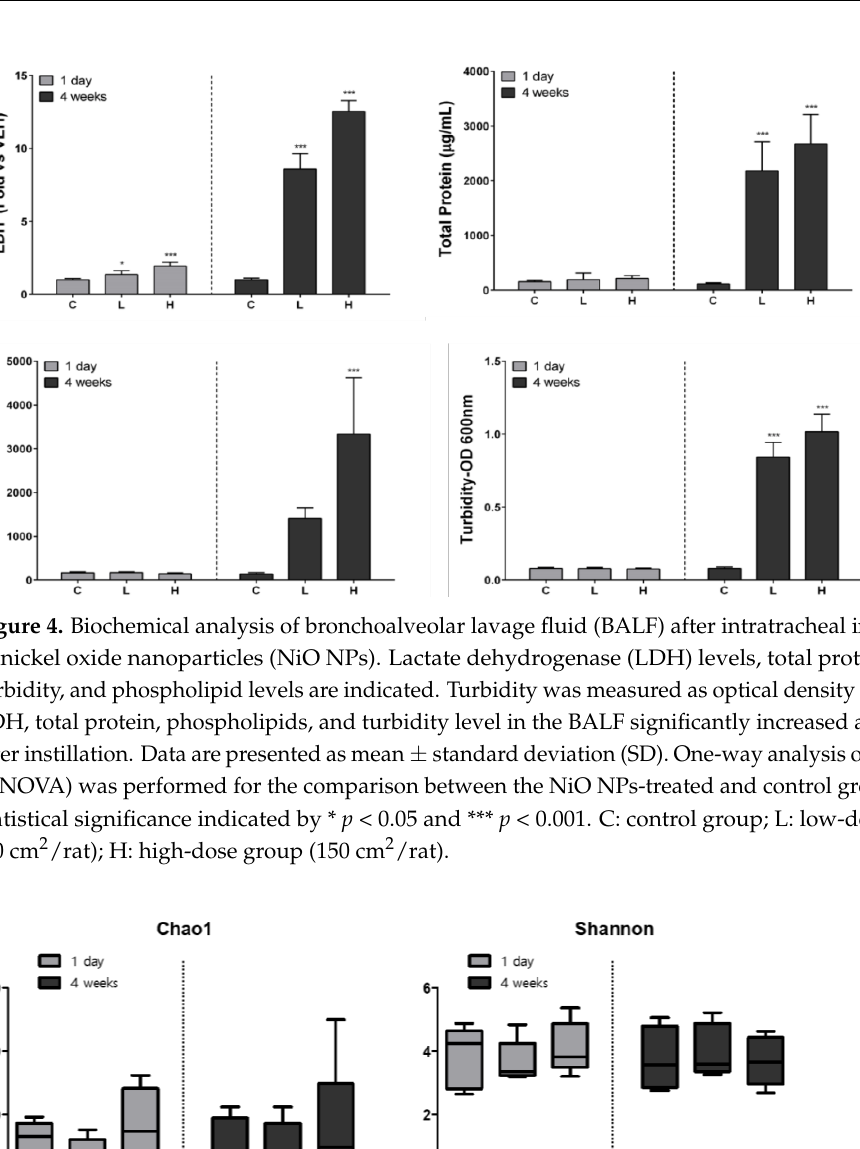
Figure 5. Alpha diversity, which estimates bacterial diversity and species richness. Bacterial diversity (Shannon; right side) and richness estimates (chao1; left) are divided into two groups, reflecting 1 day (light gray) and 4 weeks (dark gray) after intratracheal instillation of nickel oxide nanoparticles (NiO NPs), by using a boxplot. Community diversity and richness were evaluated using the alpha diversity and were not significantly different between exposure groups of NiO NPs and control group. Median values are shown as a line within the box and error bars indicate the standard error of the samples C: control group; L: low-dose group (50 cm 2 /rat); H: high-dose group (150 cm 2